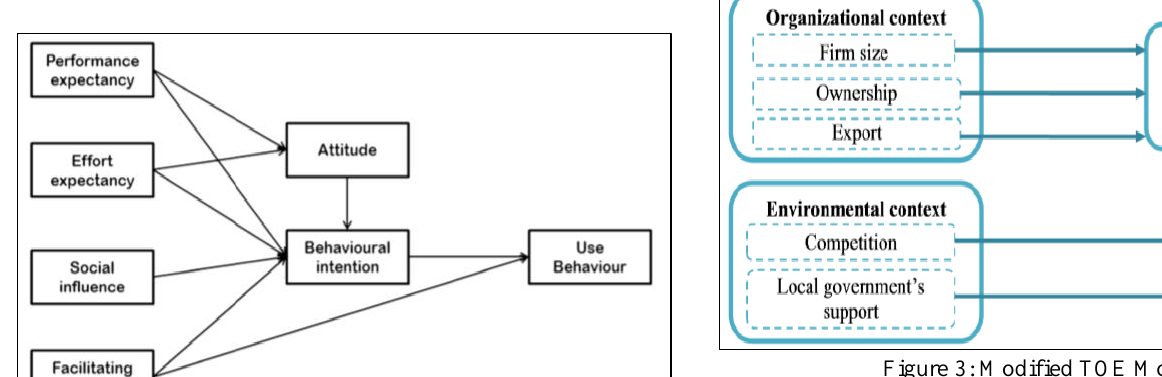
Figure 3: Modified TOE Model. Source: [25].